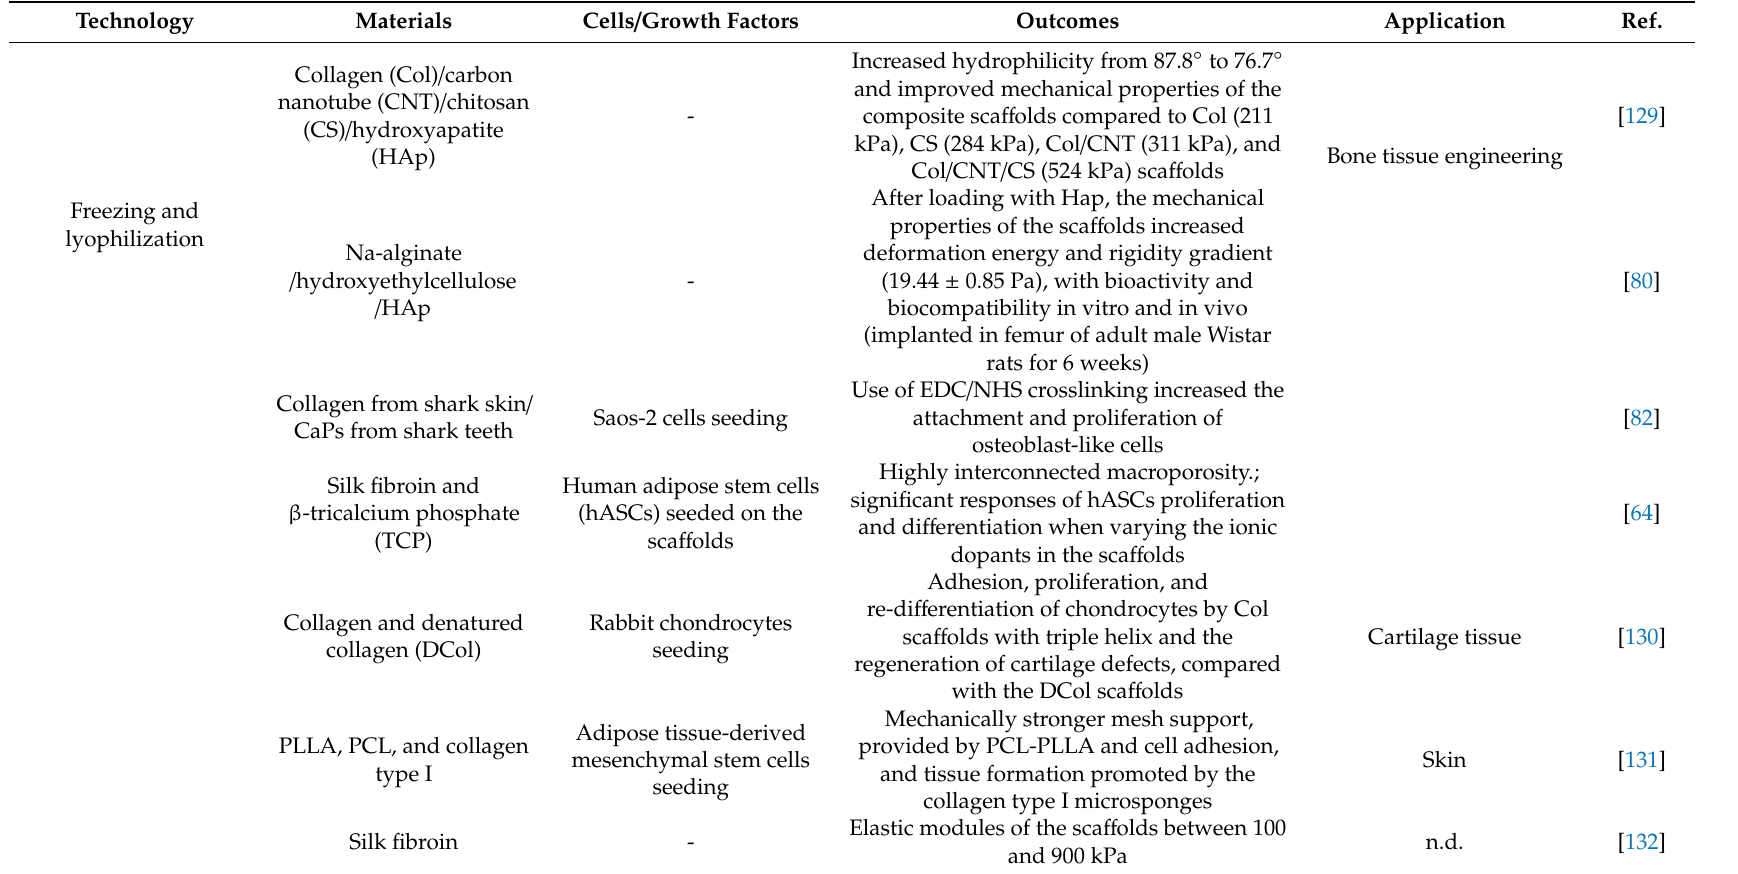
Table 1. The most recent studies of cellular and acellular 3D porous sca ff old strategies for TE